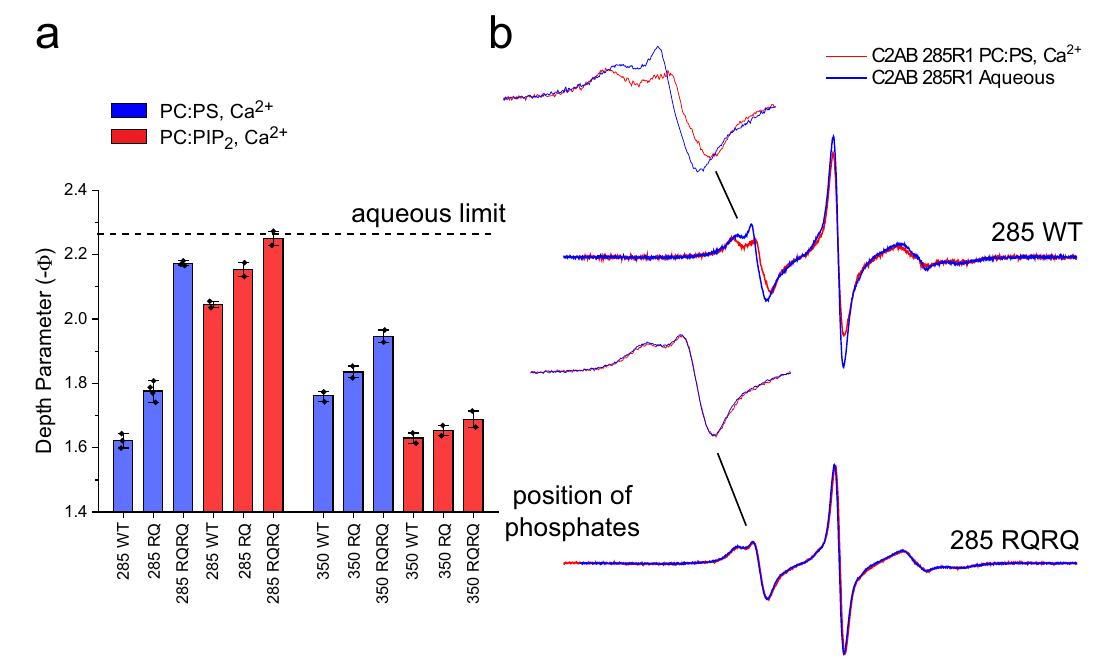
Fig. 3 Mutating the arginine apex reduces or eliminates membrane contact by the arginine apex. a power saturation indicates that the RQ and RQRQ mutations reduce or eliminate membrane contact. Vesicles were composed of POPC:POPS (80:20) or POPC:PIP 2 (95:5). The bars indicate mean values with outlying points. The points represent independent samples that were power saturated. Two independent measurements were made for POPC:PIP 2 samples. The 285R1 samples in POPC:POPS were repeated three times with the 285RQ sample repeated four times. The 350R1 WT sample in POPC:POPS was repeated three times. b EPR spectra obtained from site 285 for the pseudo wild-type (WT) and RQRQ mutant. EPR spectra are identical in the absence or presence of membranes for the RQRQ mutant. A depth parameter of 2 is obtained for an R1 label that lies ~4 Å from the lipid phosphate. When the label is further than 6 or 7 Å from the phosphates, the depth parameter becomes independent of label